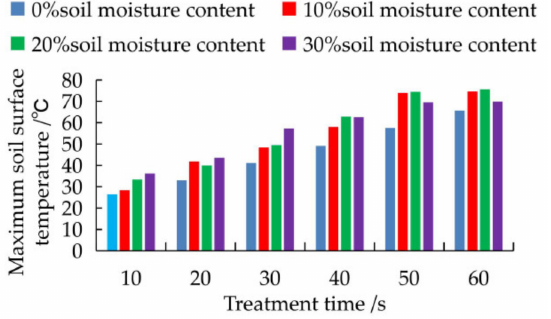
Figure 13. Soil surface temperature under 2 kW microwave output power.